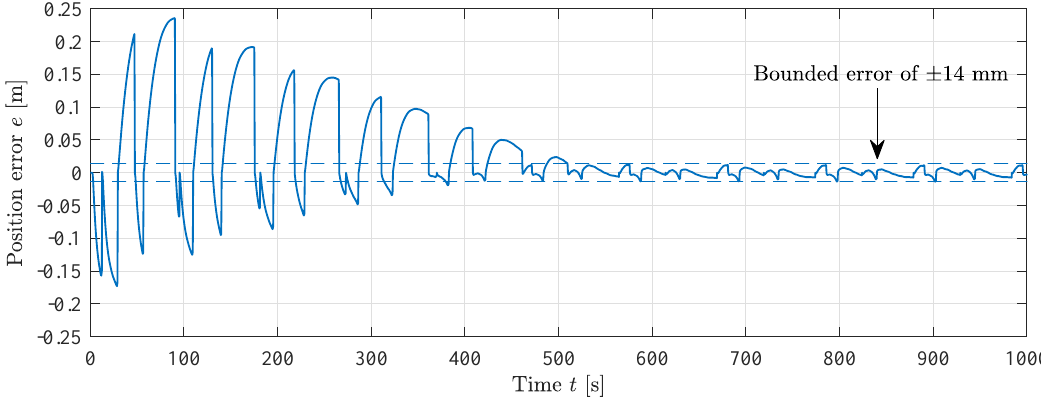
Figure 25. Position error during sign-sign feedforward experiment, γ = 0.1 m − 1